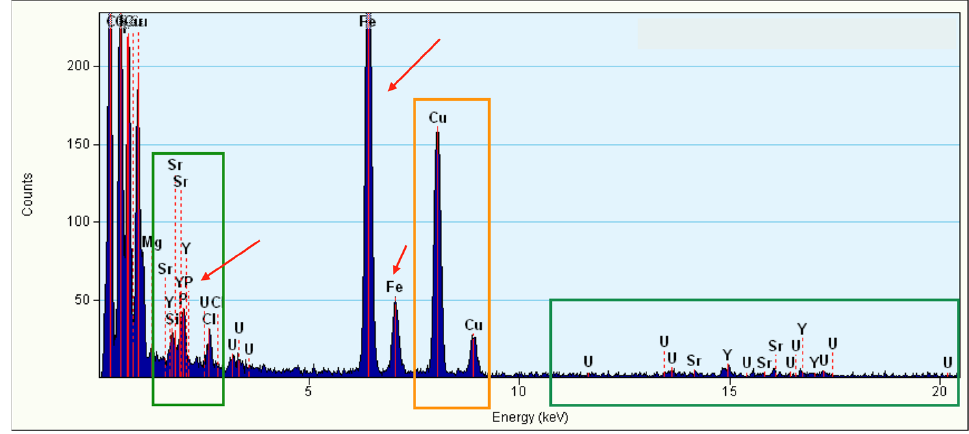
Figure 9. EDS spectrum acquired in TEM mode for a Phy@Fe 3 O 4 NPs sample. The orange boxes highlight the contributions from contamination on the sample grid, whereas the green box highlights the signal generated by the phosphate